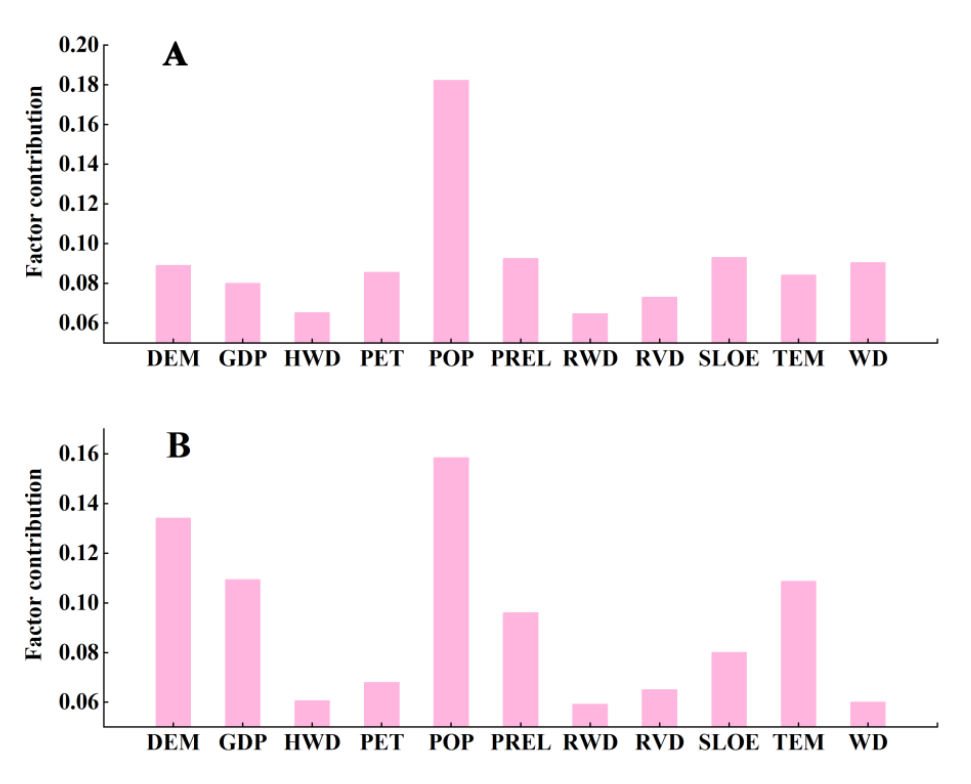
Figure 3. Expansion contribution factors of ( A ) non-grain producing cultivated land (NGPCL) and ( B ) grain-producing cultivated land (GPCL).